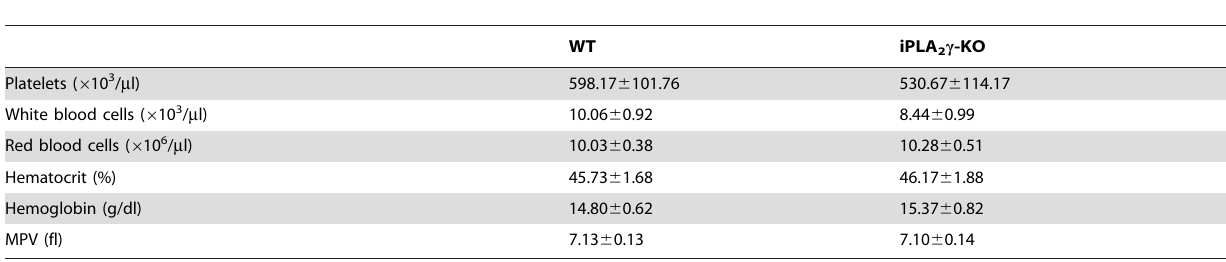
Table 1. Hematological parameters of WT and iPLA 2 c -KO mice.